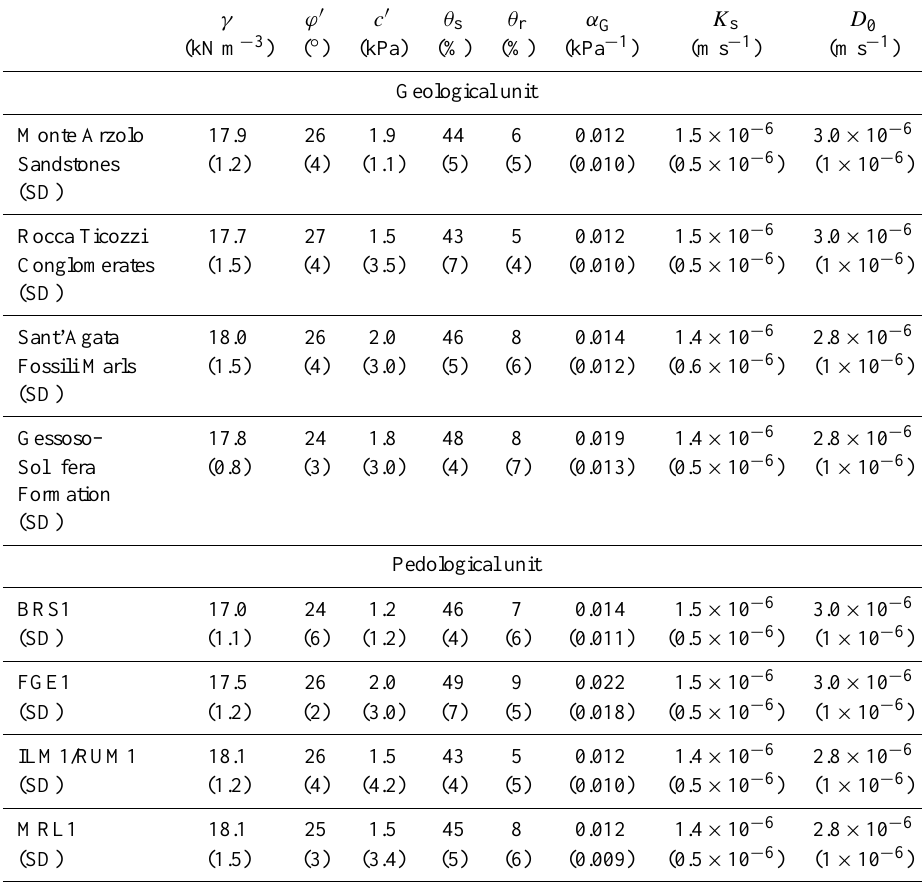
Table 5. Mean and standard deviation (SD) values of the soil parameters used as input data in TRIGRS-unsaturated. The SD values are in